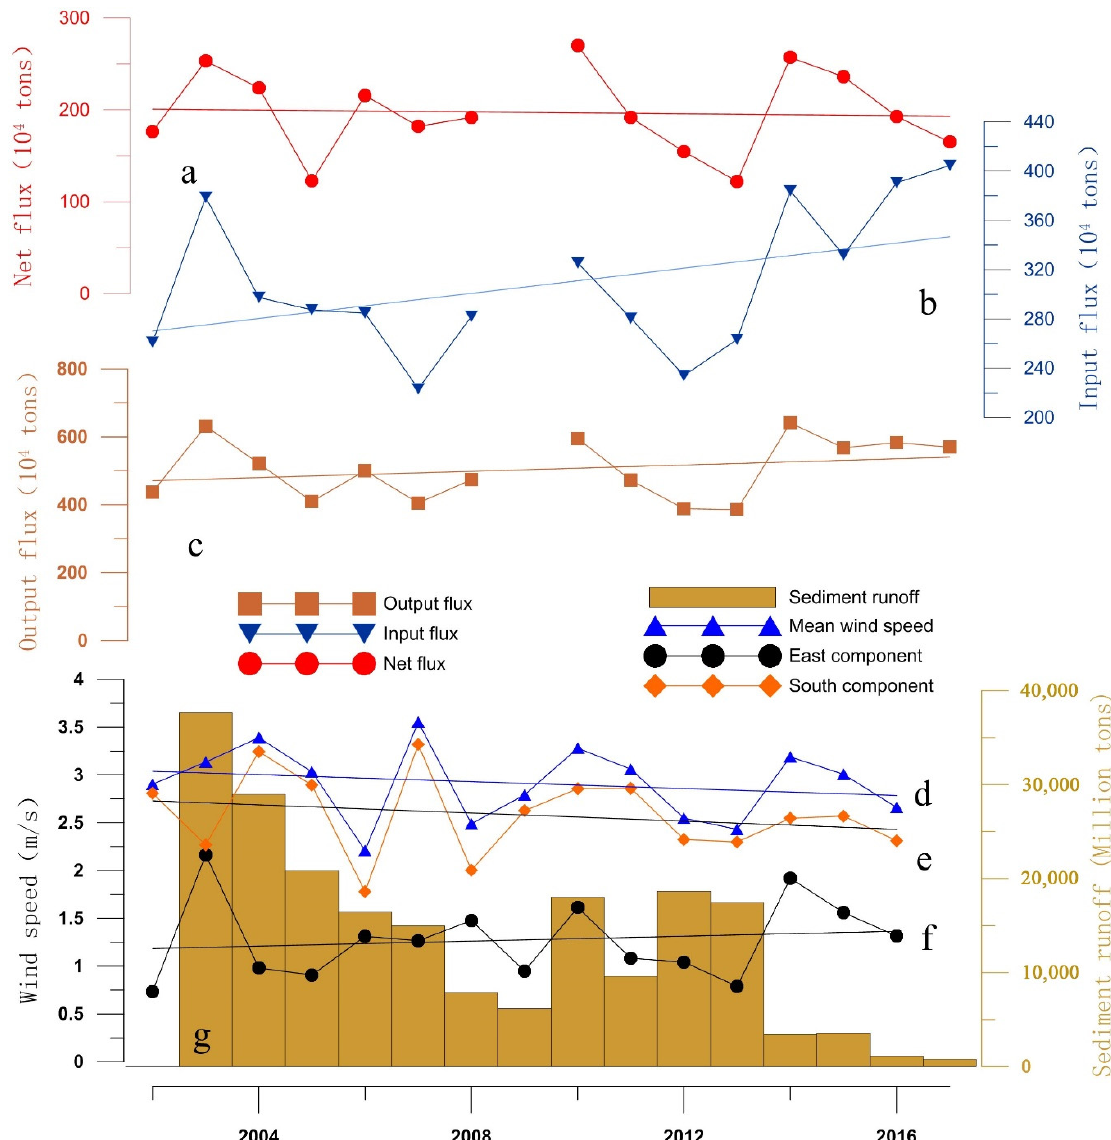
Figure 10. Suspended sediment fluxes and influencing factors in the Bohai Strait in winter (( a ) net flux, ( b ) input flux, ( c ) output flux, ( d ) wind speed, ( e ) south component of winter wind, ( f ) east component of winter wind, ( g ) sediment runoff).